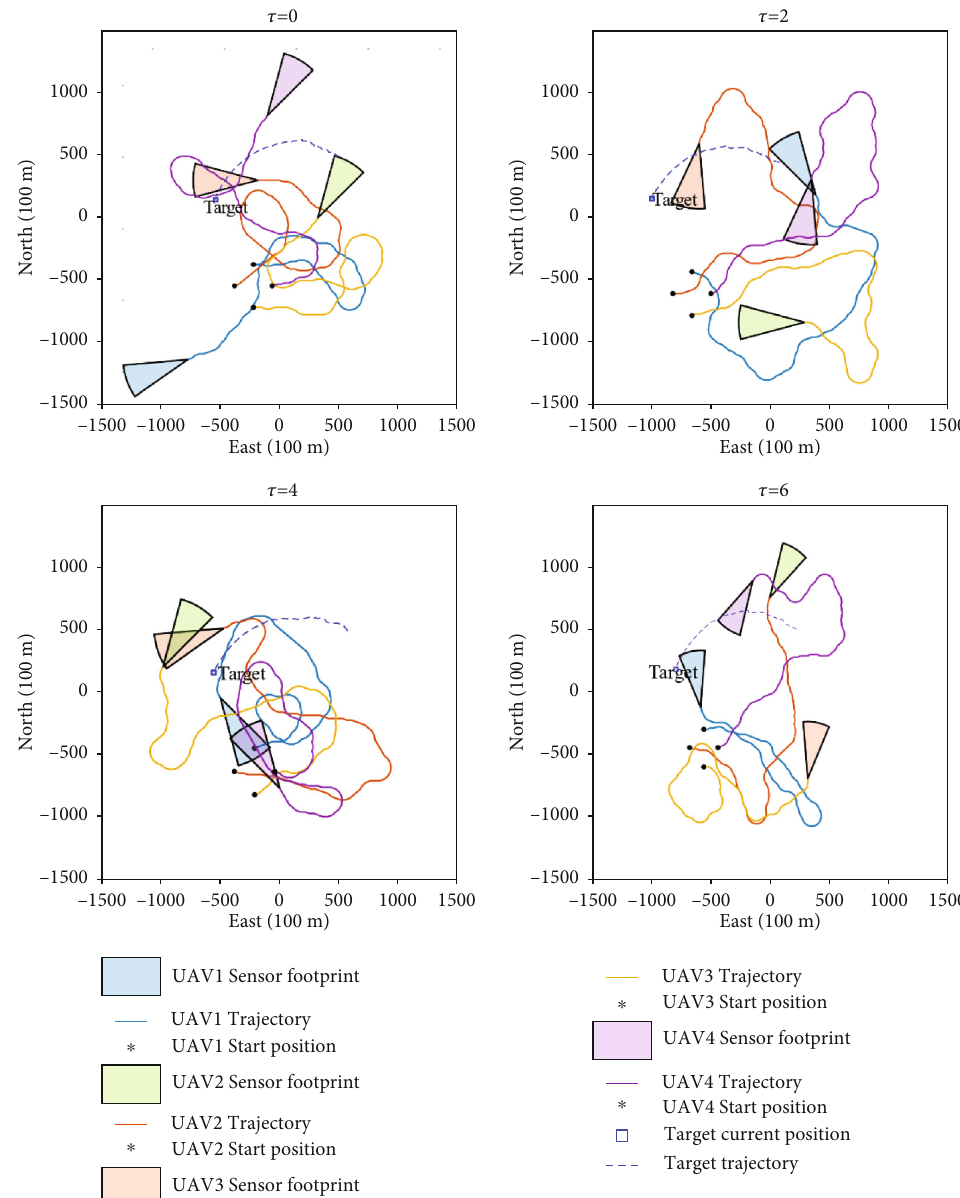
Figure 4: The simulated trajectory. In all four cases, the initial conditions except for the receding horizon step τ were the same. In the upper- left fi gure, τ = 0 stands for greedy